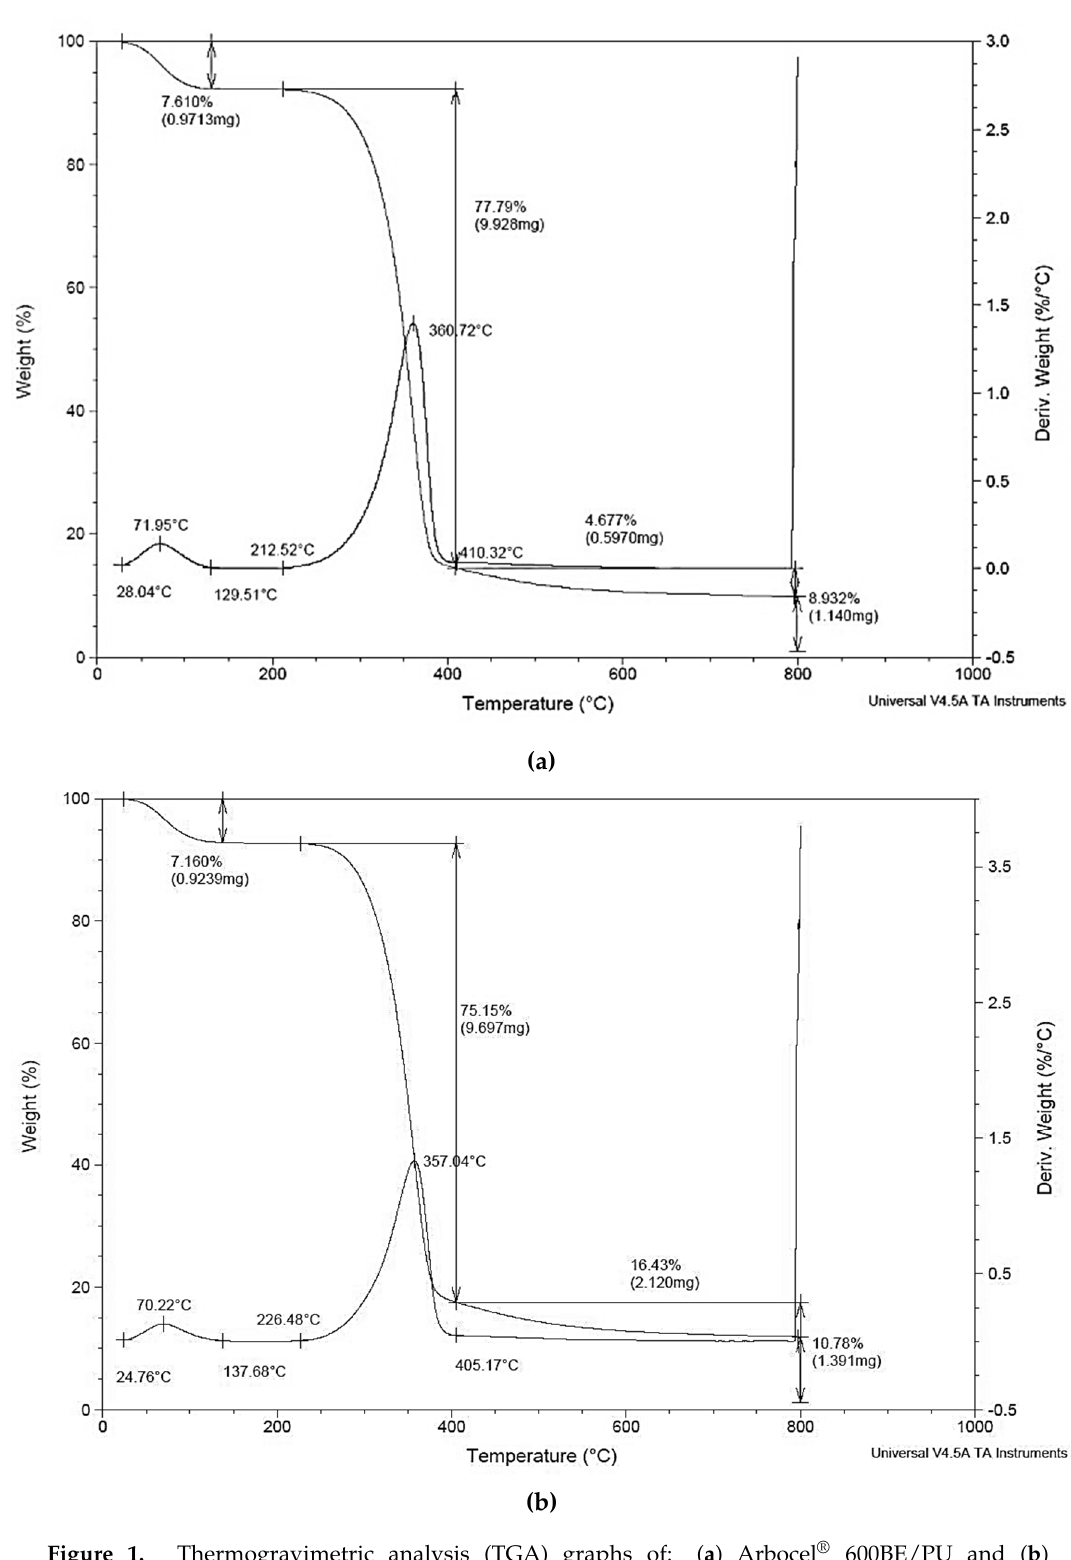
Figure 1. Thermogravimetric analysis (TGA) graphs of: ( a ) Arbocel ® 600BE/PU and ( b ) Arbocel ® BWW40.